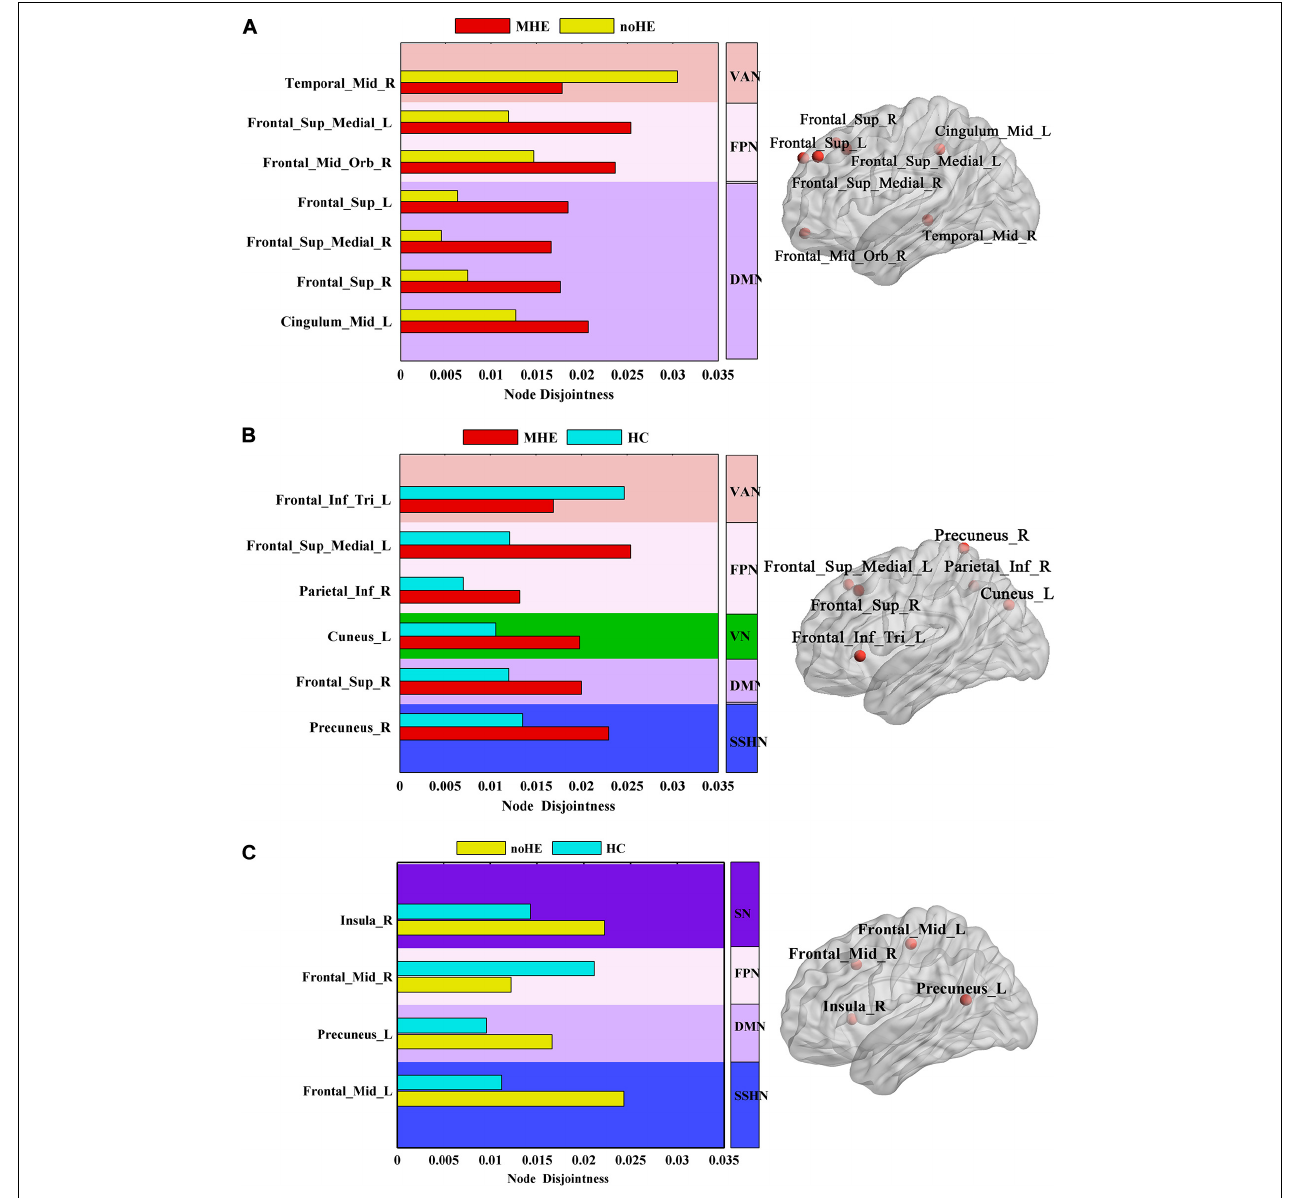
FIGURE 3 | The differences in node disjointness during brain network evolution among the three groups by one-way analysis of variance (ANOVA). (A–C) The difference regions of the brain networks and the corresponding spatial locations in post hoc comparison of MHE with noHE, MHE with HC and noHE with HC. MHE, minimal hepatic encephalopathy; noHE, non-hepatic encephalopathy; HC, health control.